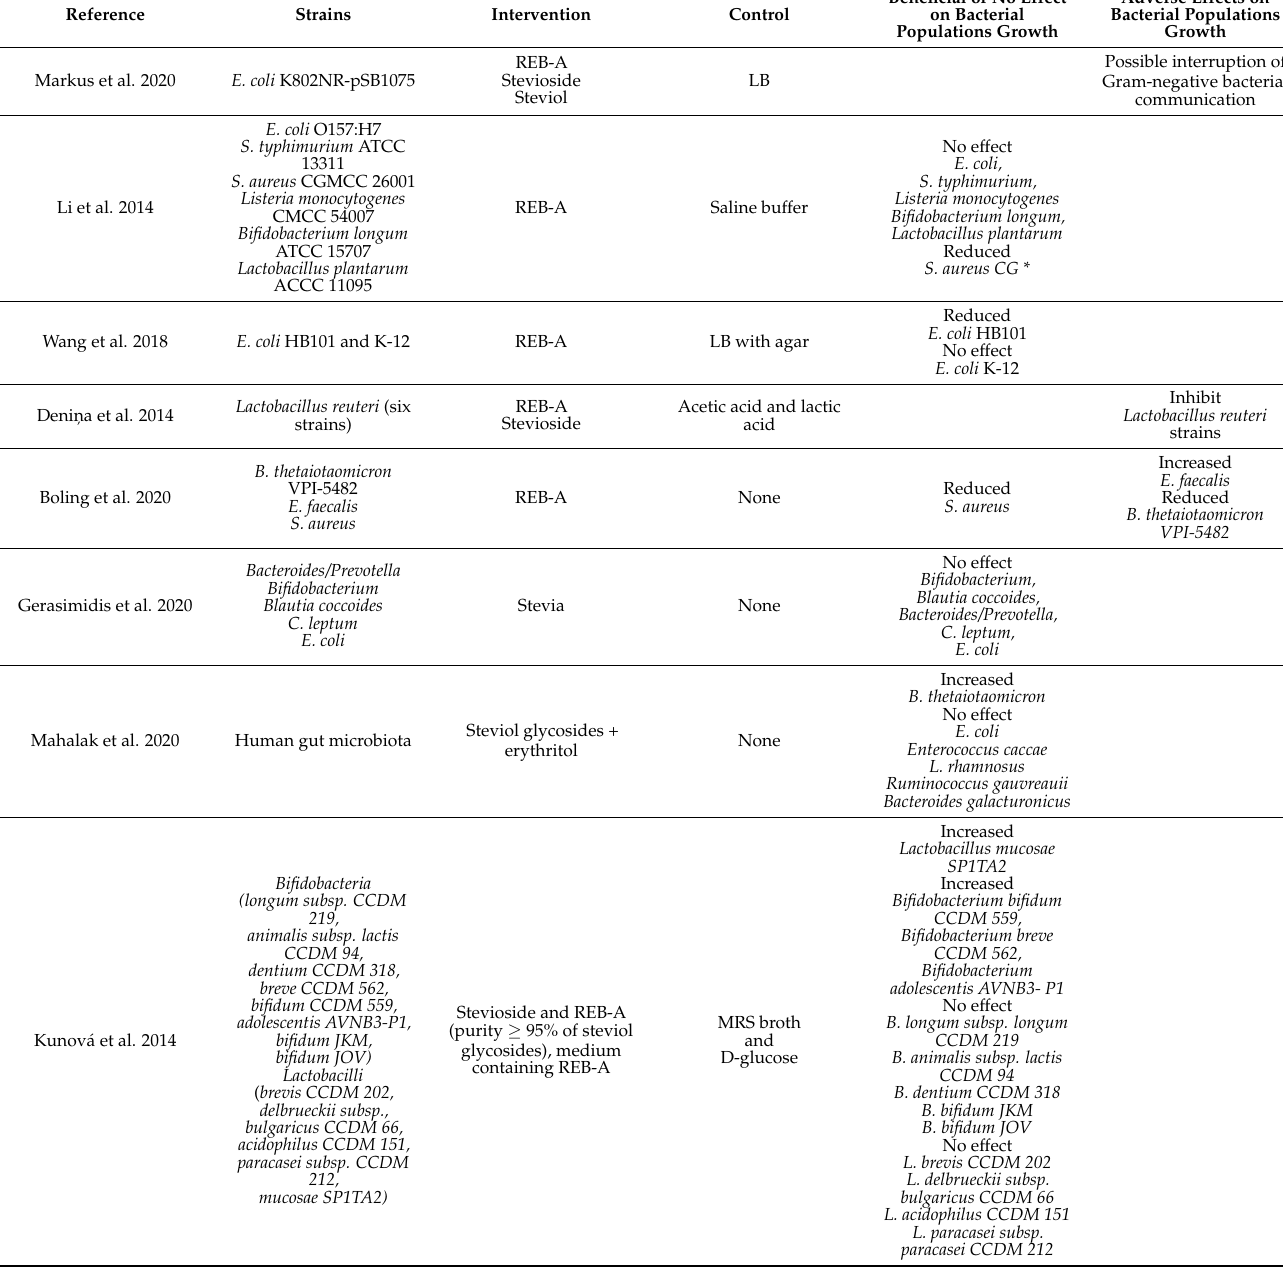
Table 1. In vitro studies presenting the effects of stevia and steviol glycosides on bacterial